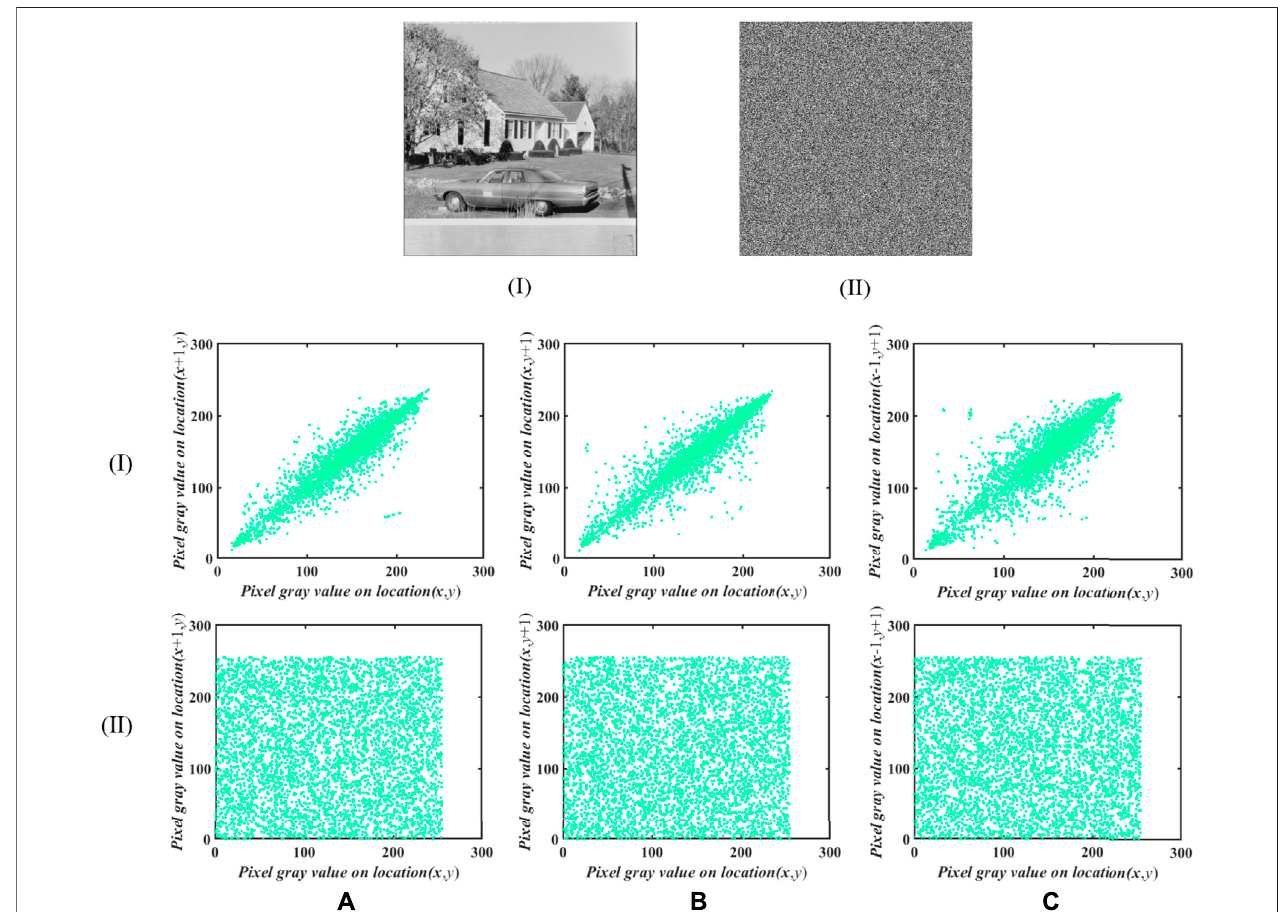
FIGURE 9 | The correlation of adjacent pixels in picture House where (I) and (II) are the plaintext picture and ciphertext picture, respectively: (A) the correlation of two horizontal adjacent pixels, (B) the correlation of two vertical adjacent pixels, and (C) the correlation of two diagonal adjacent pixels.